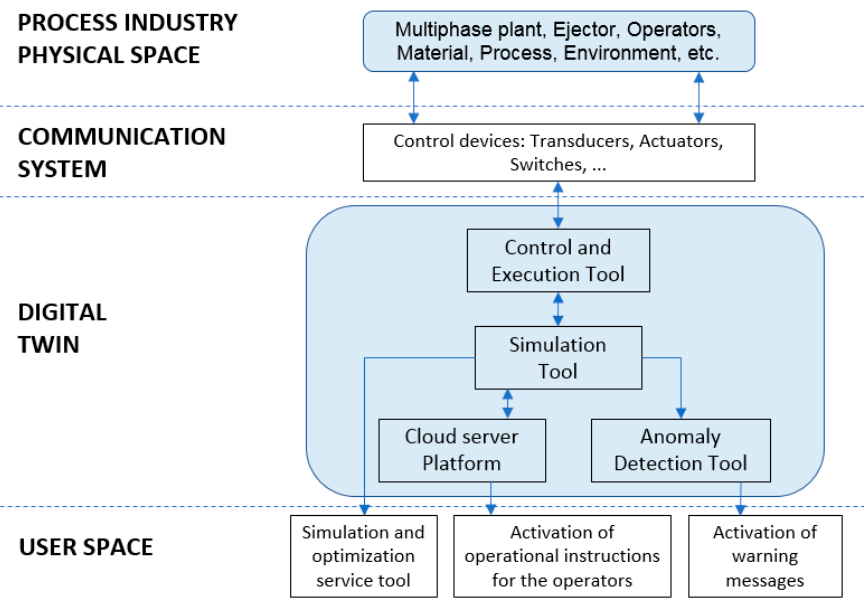
Figure 1. The reference model of the DT.